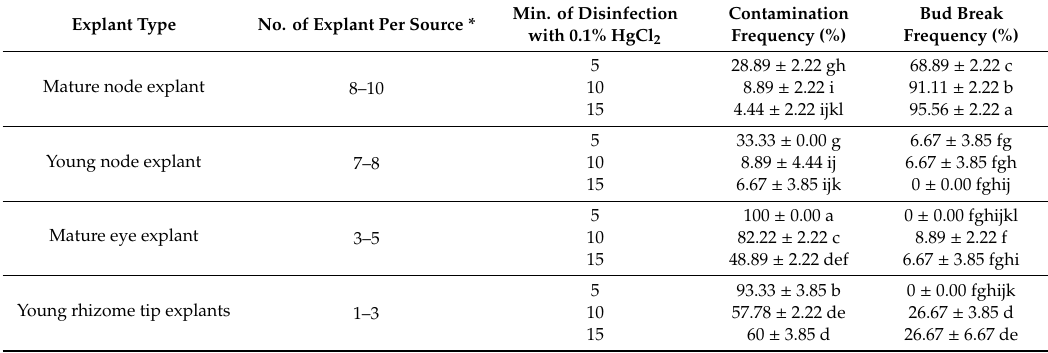
Table 1. Availability of four types of explants derived from H. coronarium ‘Hanyue’ cultured on Murashige and Skoog medium for four weeks and their contamination frequency and bud break